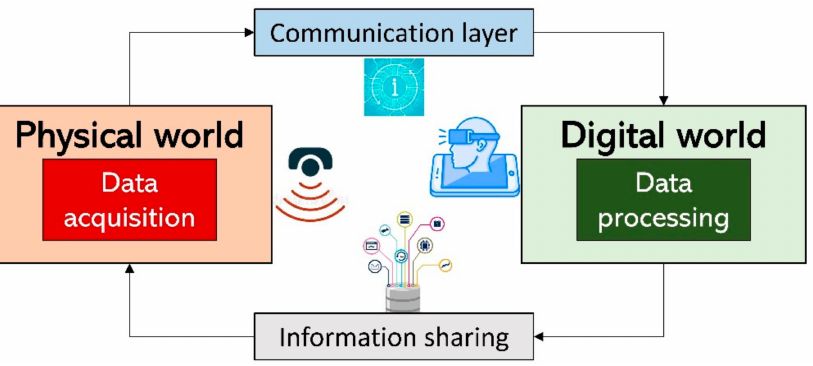
Figure 2. Digital Twin